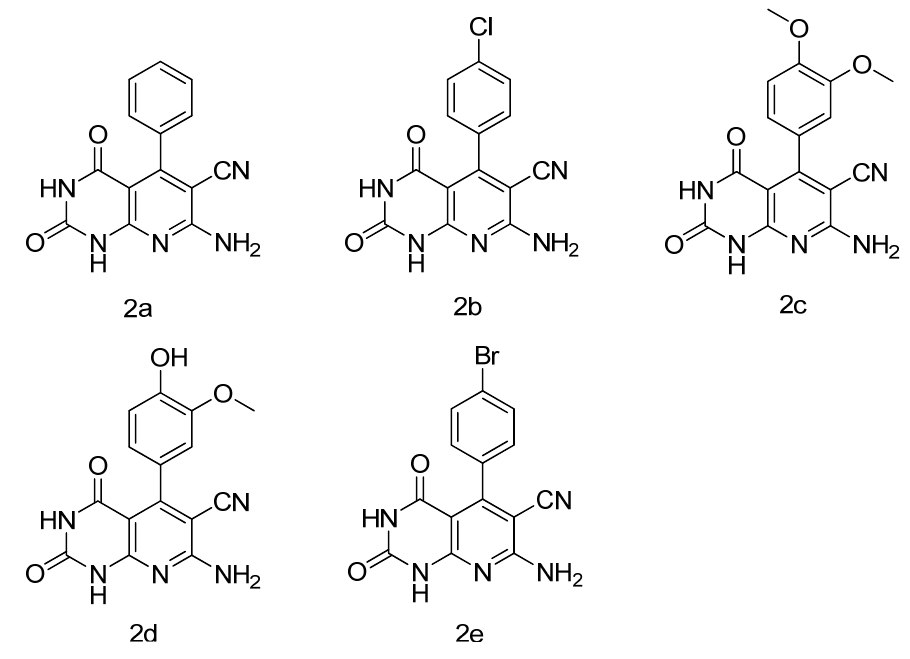
Figure 3. The chemical structure of compounds 2a–e